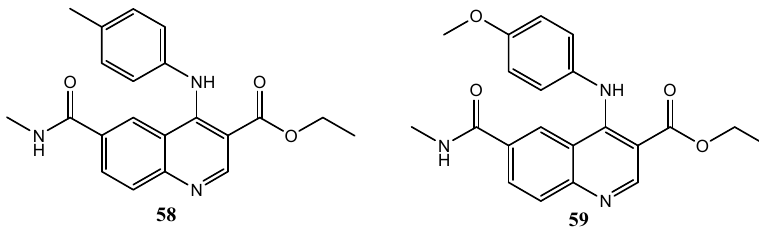
Figure 32. Quinoline-3-carboxylic acid derivatives with VEGFR-2 and VEGFR-3 inhibition activity [135].